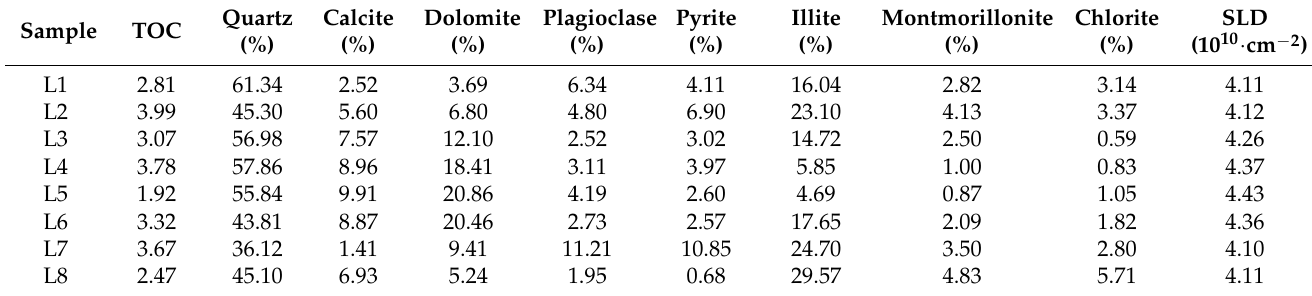
Table 1. The total organic carbon (TOC) and mineral content of shale [34].